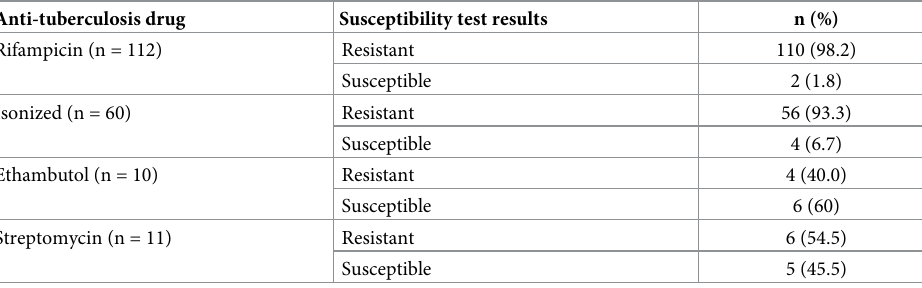
Table 2. Anti-tuberculosis drug susceptibility test results.